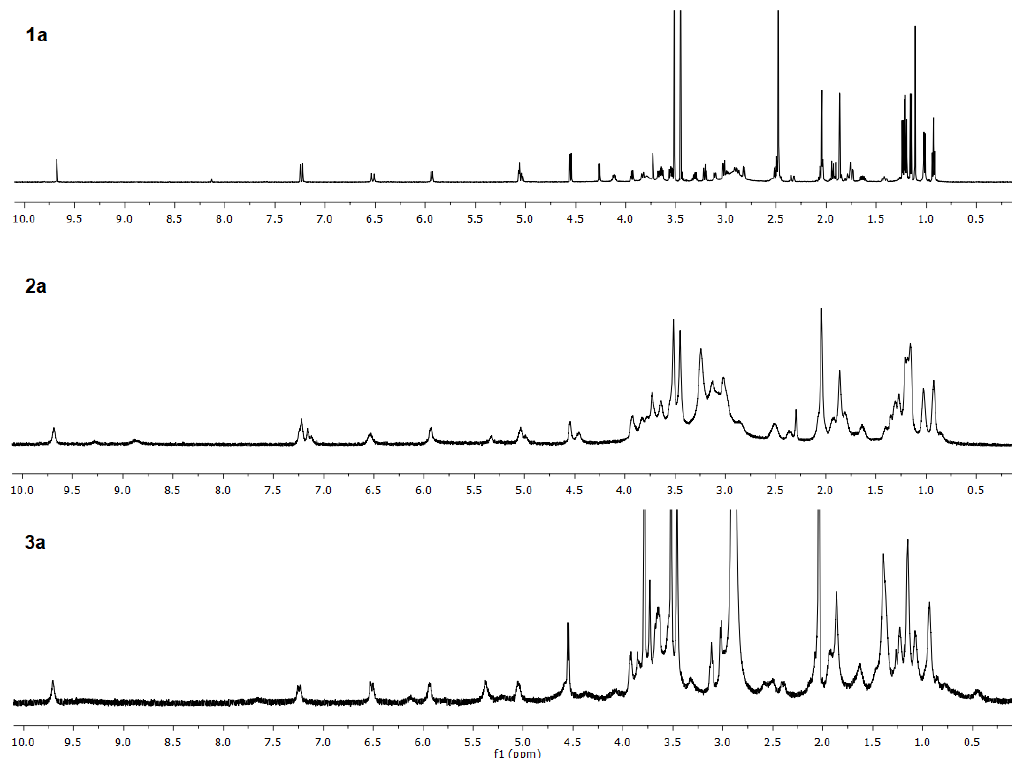
Figure 5. 1 H-NMR spectra of tylosin base ( 1а ) and complexes 2a – 3a , 10 –2 M, acetone-d 6 .